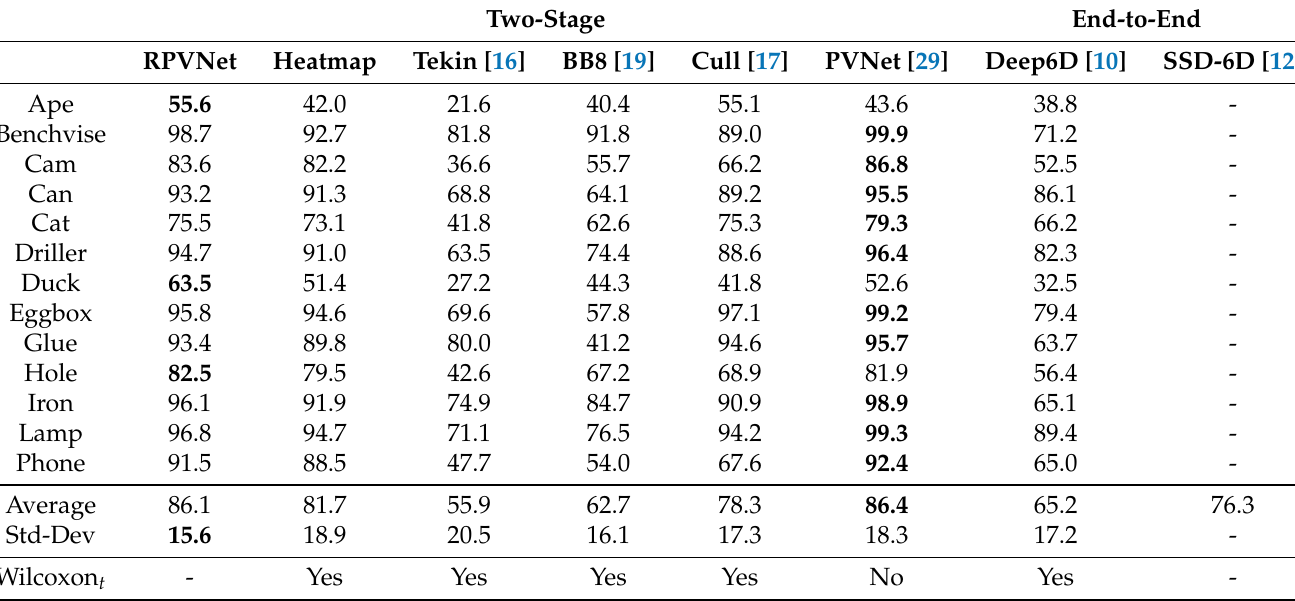
Table 1. Test results of accuracy on LINEMOD.